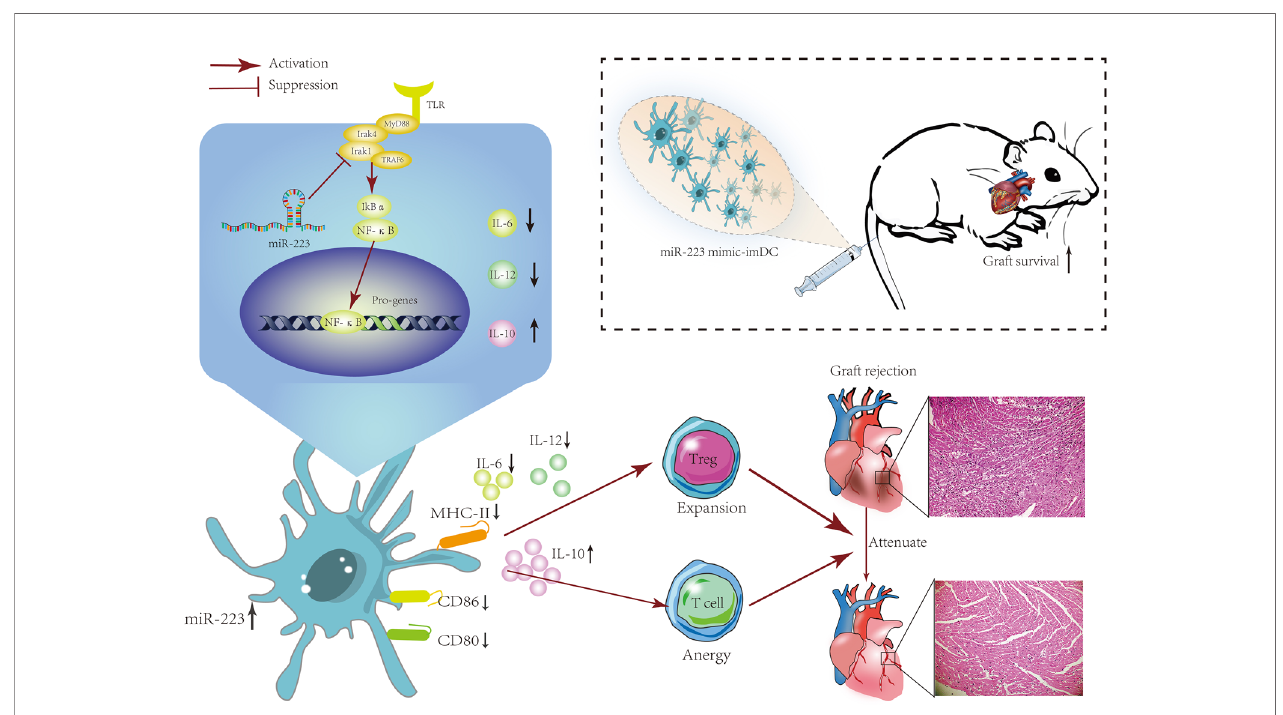
FIGURE 8 | The mechanism of miR-223-overexpressing DCs in modulating heart allograft rejection in vivo . Increasing miR-223 expression in BMDCs promotes the polarization of DCs toward a tolerogenic state by targeting Irak1, which promotes graft survival and transplant tolerance in a mouse heart transplantation model by inducing Tregs and increasing IL-10